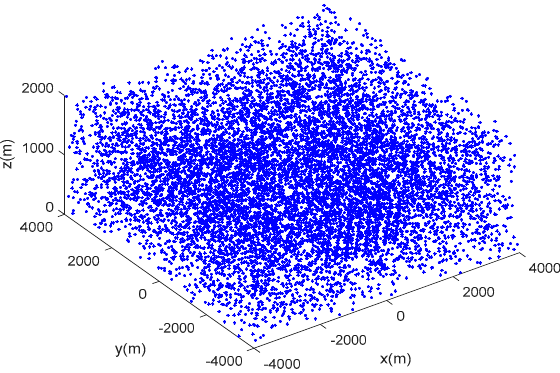
Figure 6. The real measurements with clutter in scenario 2.